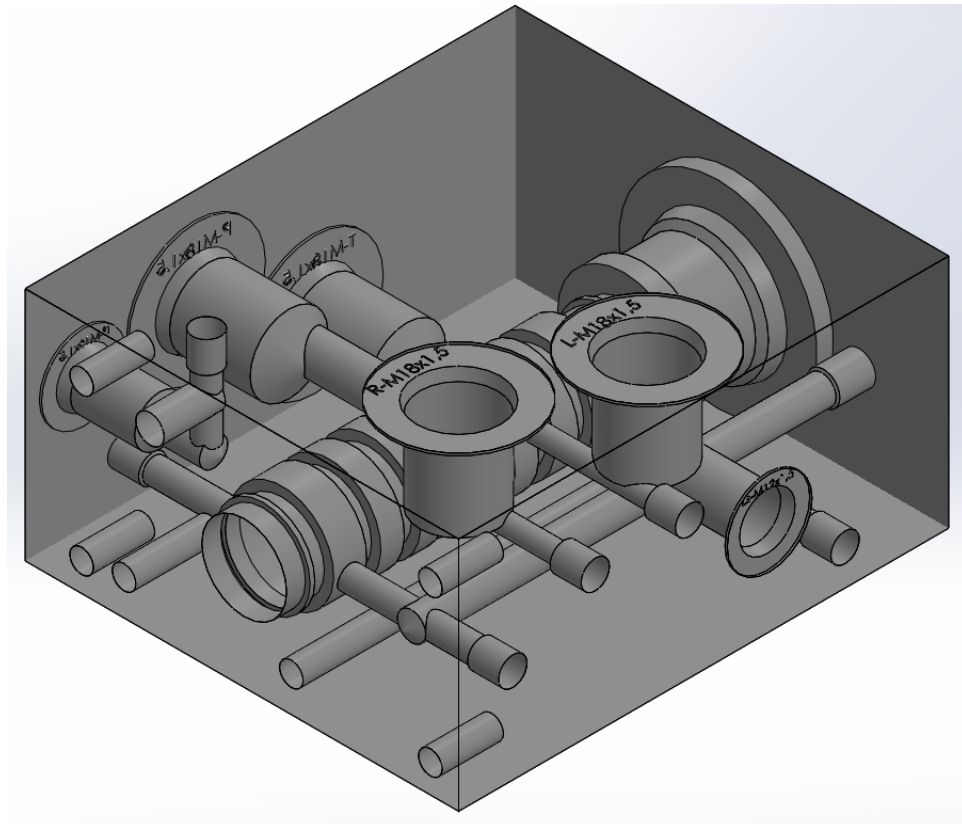
Figure 2. Geometric model of the directional spool valve